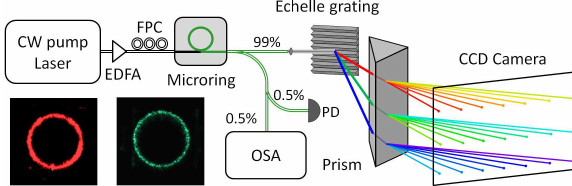
Figure 9: The simplified experimental set-up for multi-comb gener- ation and spectrum measurement. The insets show optical micro- scope images of visible microcombs glowing red and green after using a chromatic filter for each wavelength (775 nm and 517 nm, respectively). CW: continuous wave, EDFA: erbium-doped fiber am- plifier, FPC: fiber polarization controller, PD: photo detector, OSA: optical spectrum analyzer.